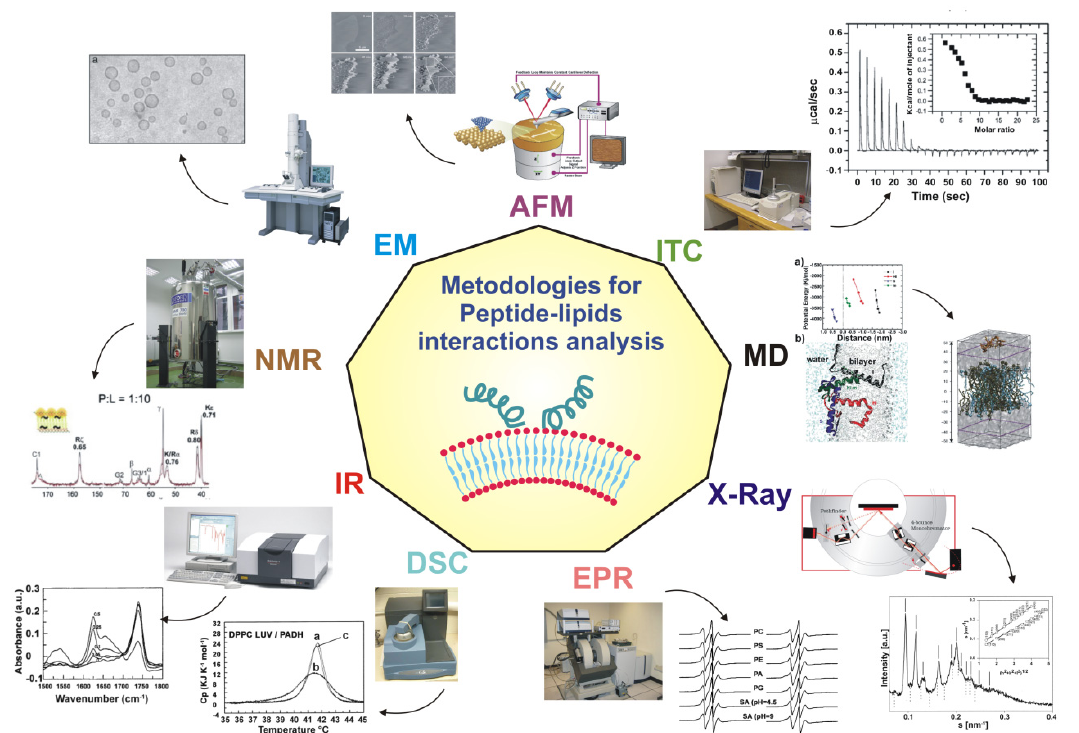
Figure 1. Schematic representation of the most recent and significant methodologies which are usually combined in biophysical studies of membrane interacting peptides providing complementary information. The list of reference is not exhaustive, a few examples are provided IR: Infrared Spectroscopy; NMR: Nuclear Magnetic Resonance; EM: Electron Microscopy; AFM: Atomic Force Microscopy; ITC: Isothermal Calorimetry; MD: Molecular Dynamics; X-ray: X-ray Crystallography; EPR: Electron Paramagnetic Resonance